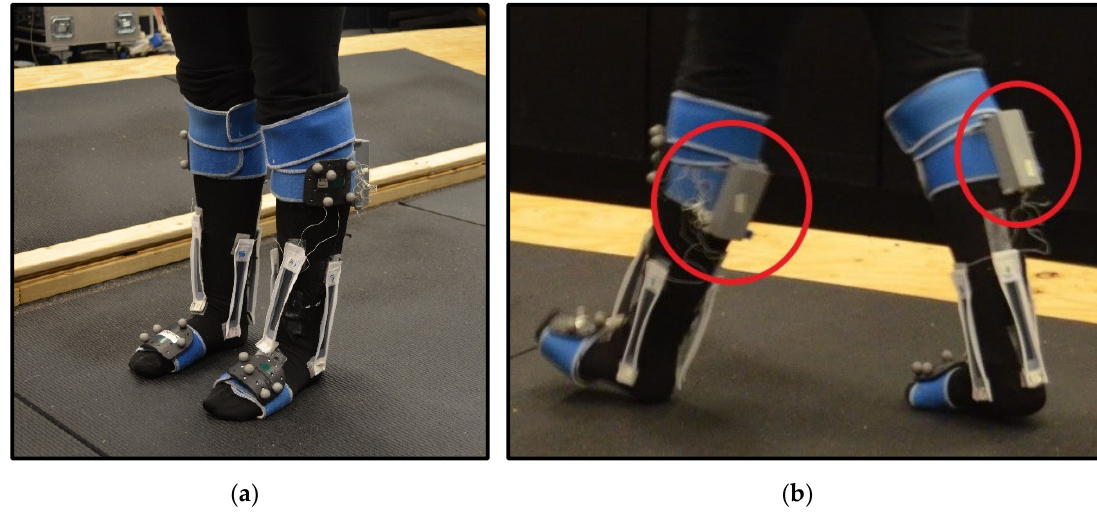
Figure 10. ( a ) Second sock prototype iteration; ( b ) 3D printed enclosures circled in red in the right image.